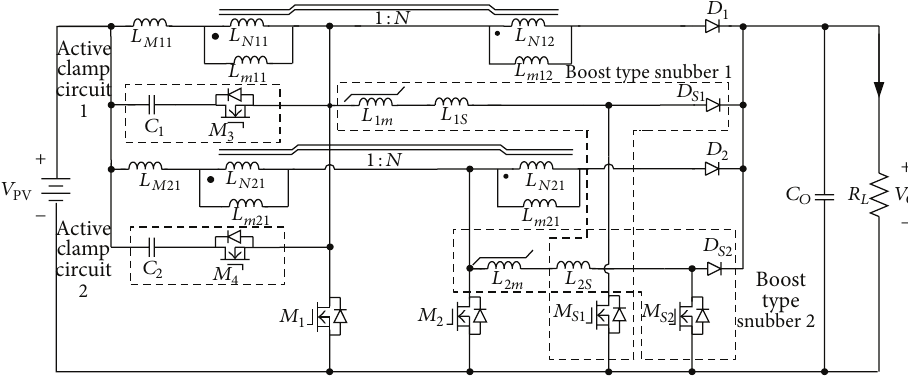
Figure 3: Schematic diagram of interleaved coupled-inductor boost converter with boost type snubber.